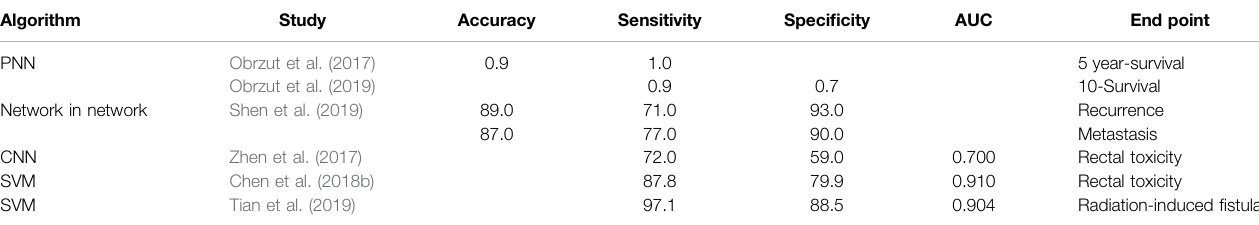
TABLE 2 | The results from machine learning.